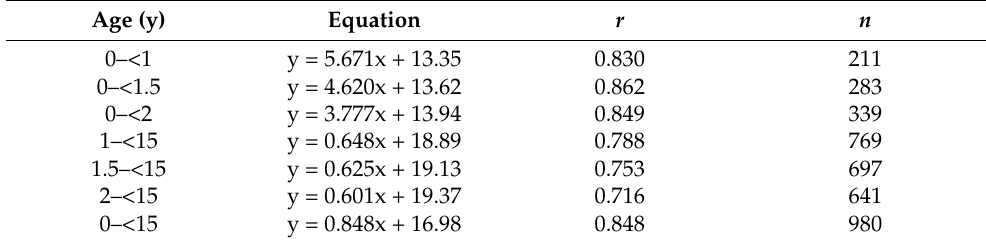
Table 1. Age range and results of linear regression between CTDIvol and age.